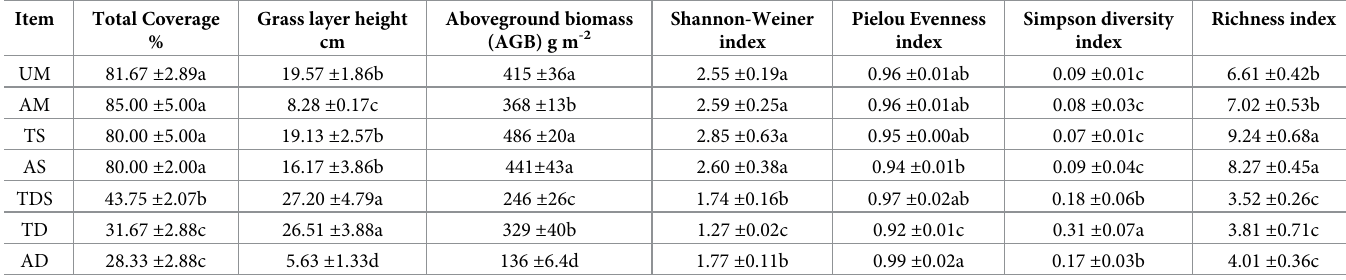
Note: Data are presented as the mean ± SD; Different small letters in the same row mean significant difference at 0.05 level. TS, Temperate steppe; AM, Alpine meadow; AS, Alpine steppe; UM, Upland meadow; AD, Alpine desert; TDS, Temperate Desert Steppe; TD, Temperate Desert. SD, Standard deviation; CV: Coefficient of Variation; AGB: Aboveground